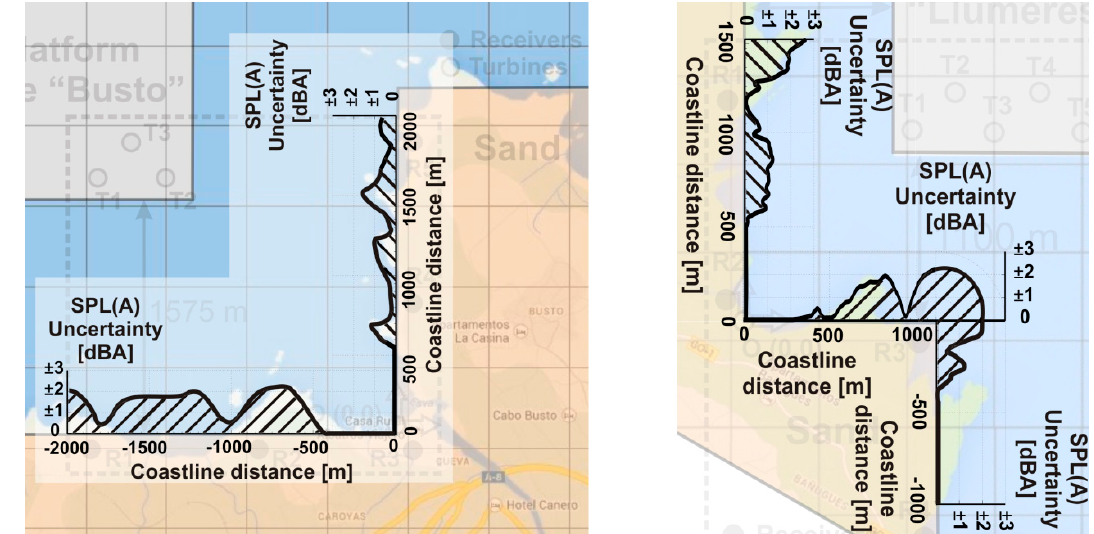
Figure 6. Estimated uncertainties for the sound pressure levels (SPL)(A) along the at Cape Busto ( left ) and Llumeres ( right ) due to the geometrical simplification of the model.